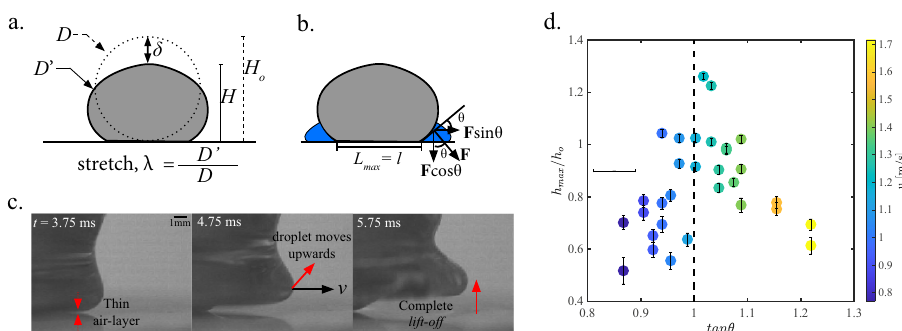
Fig. 2 Hydrogel sphere deformation leads to lift-off of resting droplet. a Schematic of the deformation of the impacting soft hydrogel sphere. The initial diameter D increases on impact, leading to sphere height reduction from H o . Stretch λ is de fi ned as the ratio of diameter deformation ( D 0 = D , where D 0 is the instantaneous deformed diameter). The indentation is de fi ned as δ = ( H o − H ). b The deformation of the hydrogel spheres leads to radial base propagation, with the curved sides of the elongating sphere applying a normal force, F , on the droplet. The angle θ represents the curved side of the sphere with the surface (measured when L max = l ). The vertical and horizontal components of F leads to rebound and radial propagation of the droplet respectively. c The two force components affect the droplet in different ways. The horizontal component pushes the droplet rim radially outwards which glides over the thin air layer on the hydrophobic surface (3.75 ms). The vertical force component pushes the rim down, and the rim bounces off the air layer which acts as a spring (4.75 ms). Finally, we see complete lift-off (5.75 ms). Images showing the same drop event shown in Fig. 1a. d The angle θ plays an important role in controlling lift-off. The angle θ grows as velocity increases. At lower θ values F cos θ dominates, leading to lift-off cases with greater lift-height h max . h max is largest at tan θ (cid:1) 1. Uncertainty bands are marked with a 95% con fi dence. Multiple h max values for each θ occur because of varying droplet diameter ( d